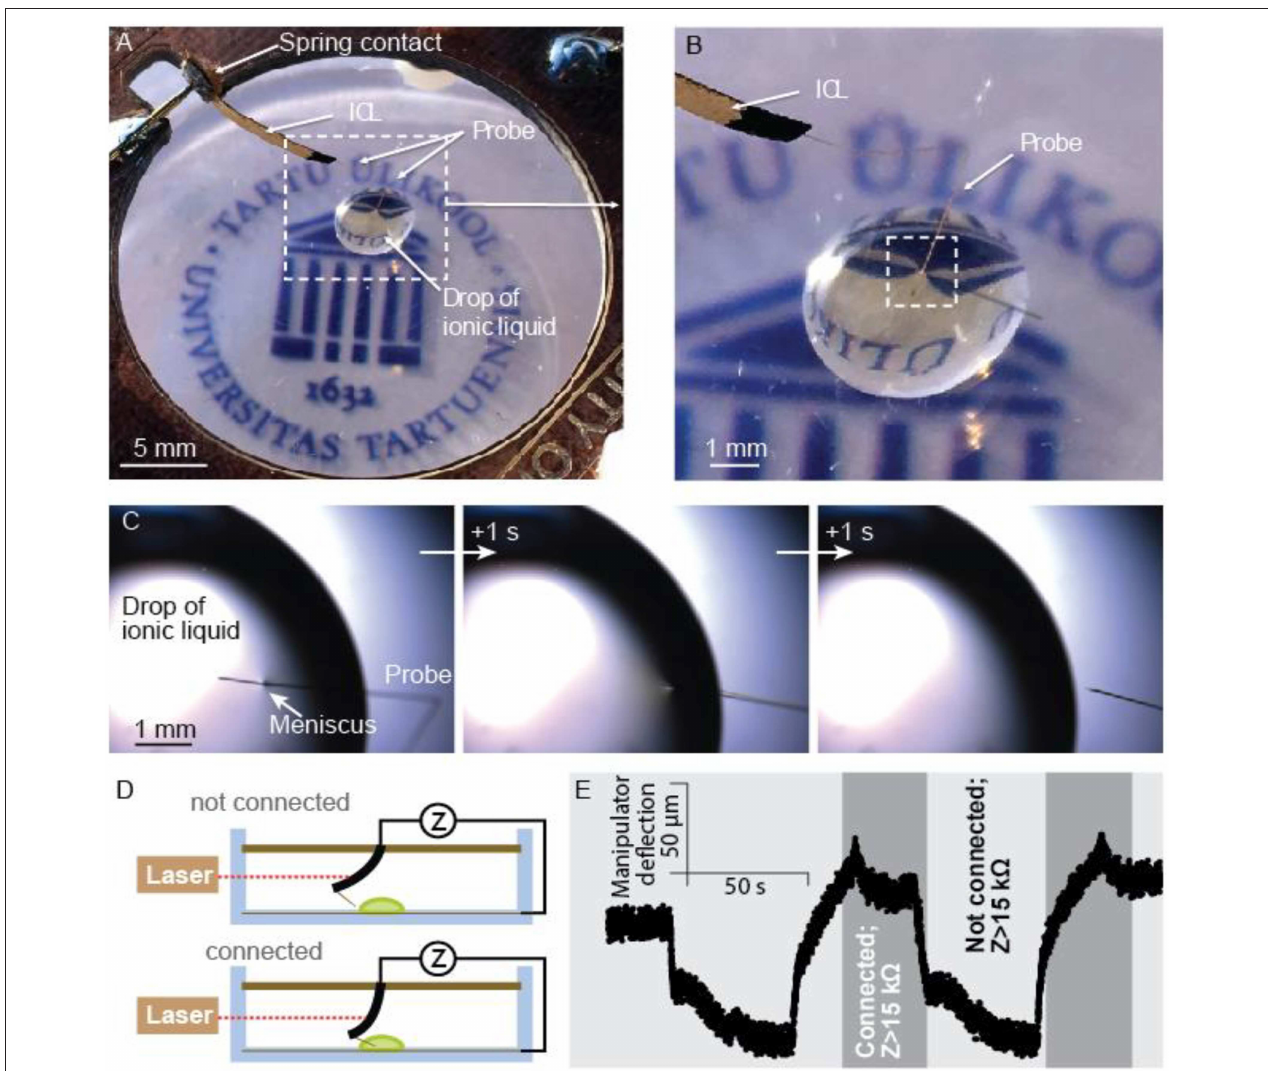
FIGURE 12 | (A) The ICL manipulator probing a drop of liquid, and (B) closeup of the same. (C) A sequence of micrographs upon breaking the contact in-between the liquid sample and the probe. (D) Schematic description of the continuity measurement setup, and (E) probe’s displacement at 5mm from the contacts and formation and loss of electrical contact to the sample monitored by EIS (1kHz, 5 mV RMS ) between the integrated probe and a counter electrode (W/Au wire) on the bottom of the Petri